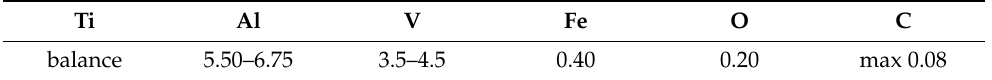
Table 1. Chemical composition Ti-6Al-4V based on attestation certificate (wt%).